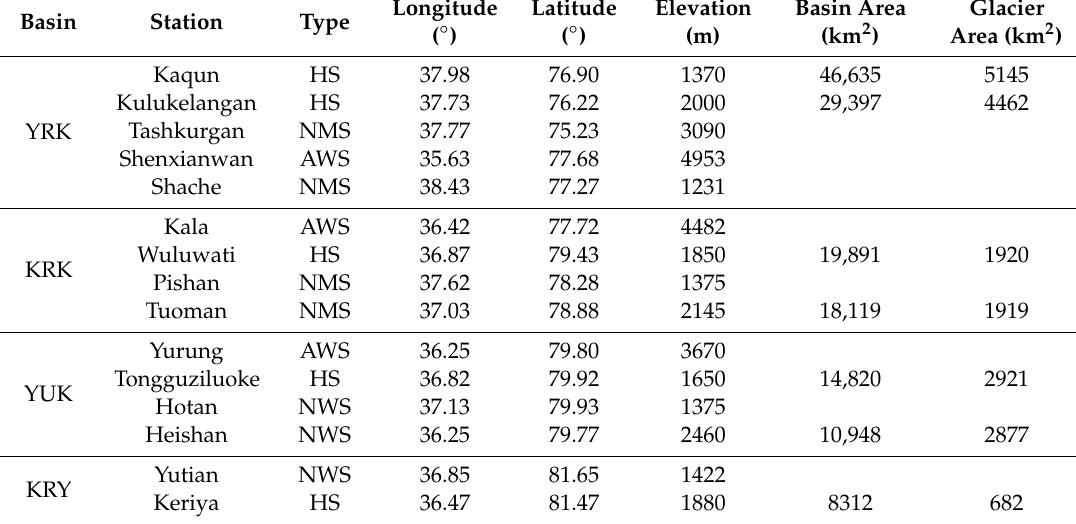
Table 1. Information from stations (Automatic Weather Station (AWS), National Meteorological Station (NMS), and Hydrological Station (HS)) in the north slope of the West Kunlun Mountains (NSWKM). Longitude Latitude Basin Station Type ( ◦ ) ( ◦